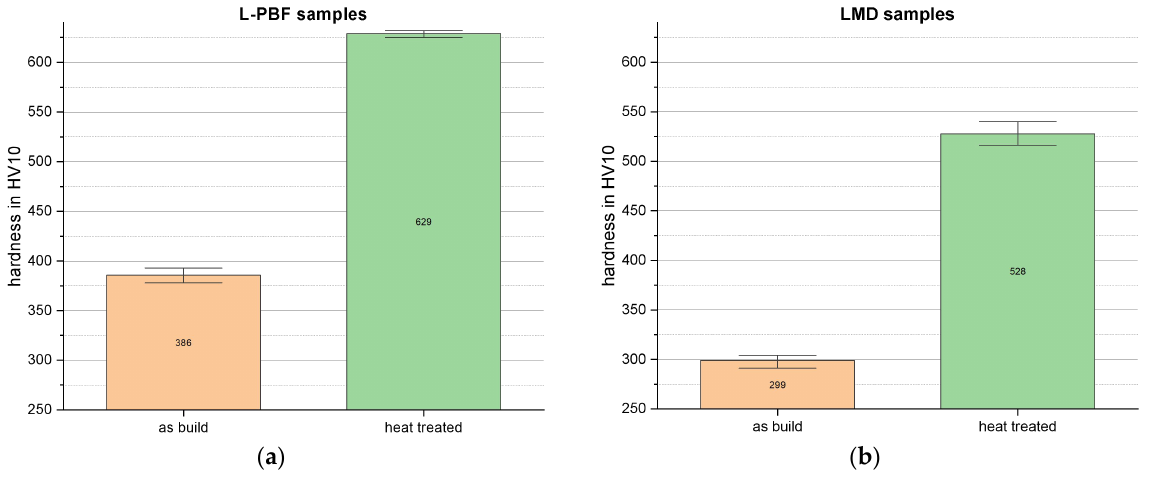
Figure 9. Comparison of measured hardness from as-built and heat-treated samples, ( a ): L-PBF- samples; ( b ): LMD samples.